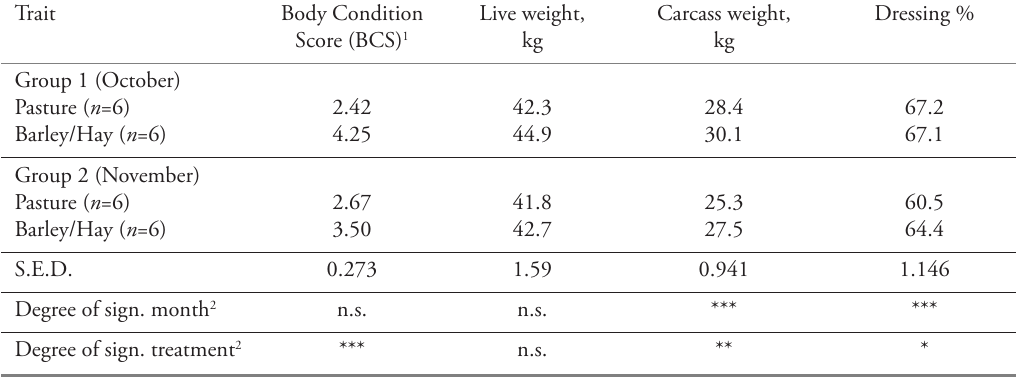
Table 1. Mean live weight and carcass parameters for fallow deer from two feeding treatments (pasture raised and barley/hay-fed), with standard errors of the difference